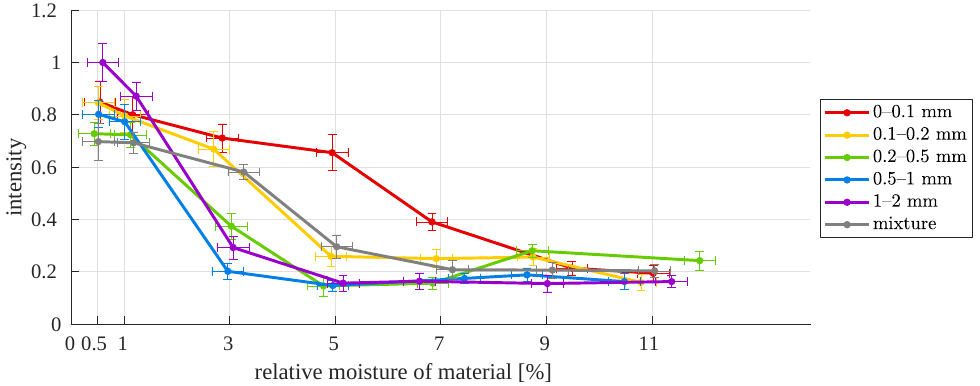
Figure 17. Image median intensity as function of relative moisture, for different particle